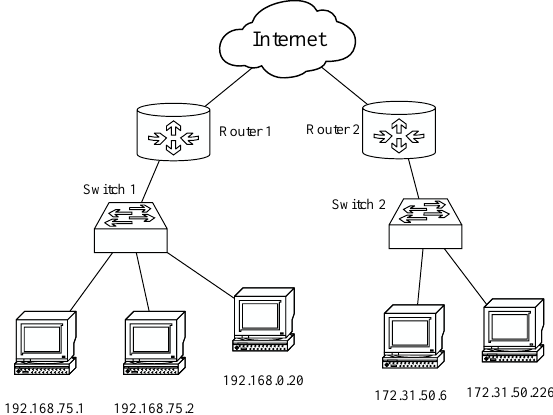
Figure 6. Testbed of the case